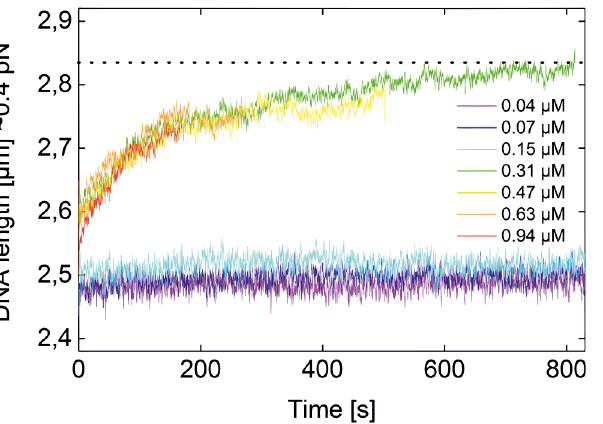
Fig 2. Kinetics of TrmBL2 binding to dsDNA at different concentrations of TrmBL2. The kinetics were measured by monitoring the change of the DNA length at a force of 0.4 pN, which linearly changes with the coverage of the DNA by the protein. The data shown were recorded from the same DNA molecule. At room temperature, the filament formation is completed (95%) within approximately 10 minutes and the final DNA length (dotted line) is